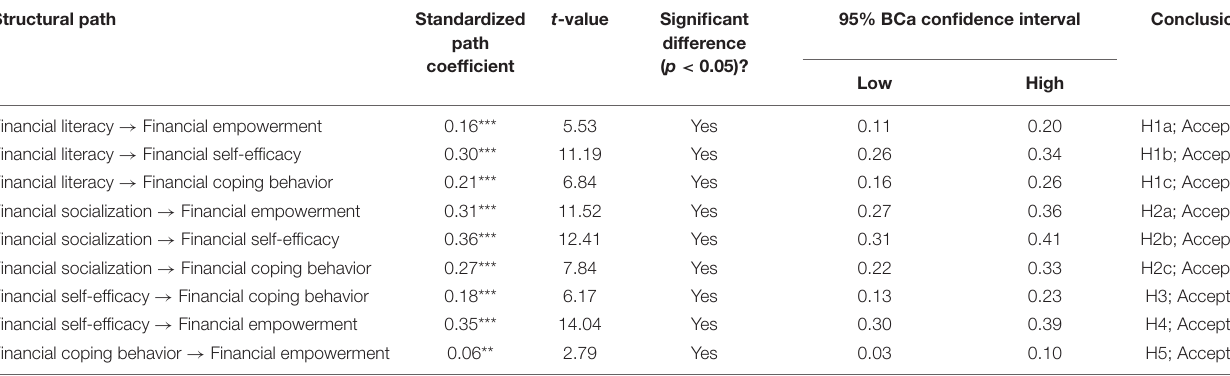
TABLE 4 | Significant testing results of the structural model path coefficients. Structural